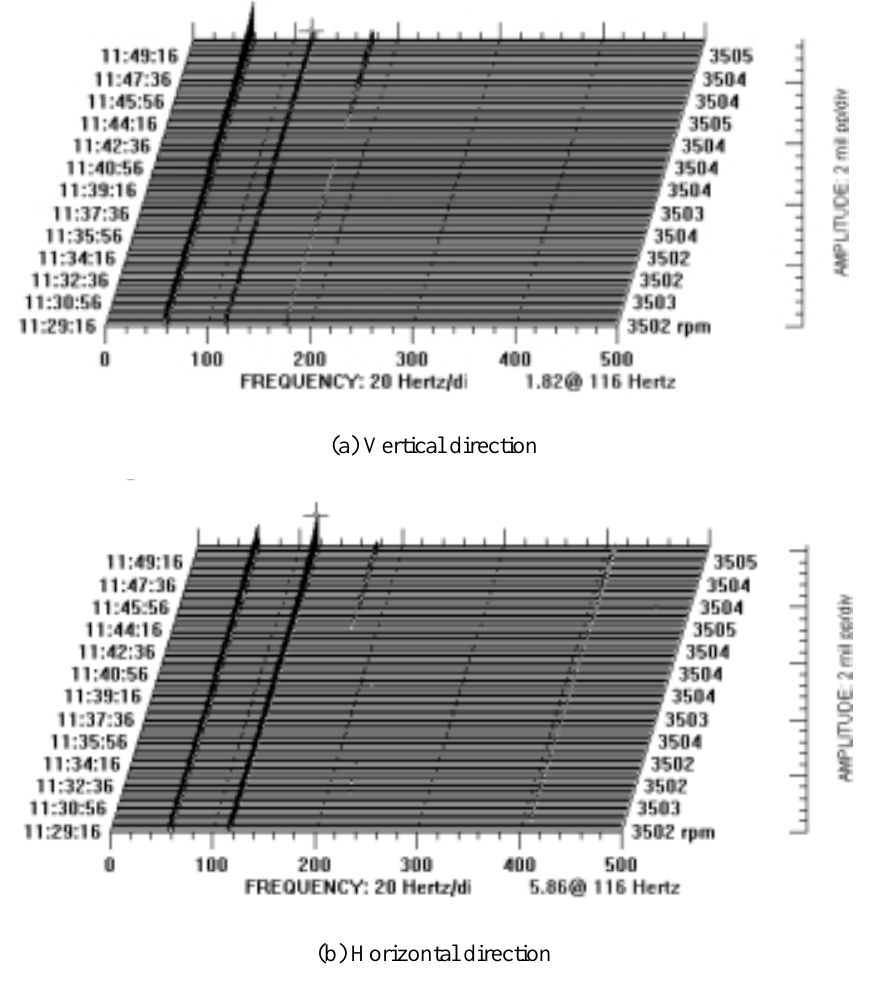
Fig. 12. Frequency waterfalls of steady state data at 3500 rpm for the 2nd shaft with 4 mm notch crack with 8 kg vertical hanging side